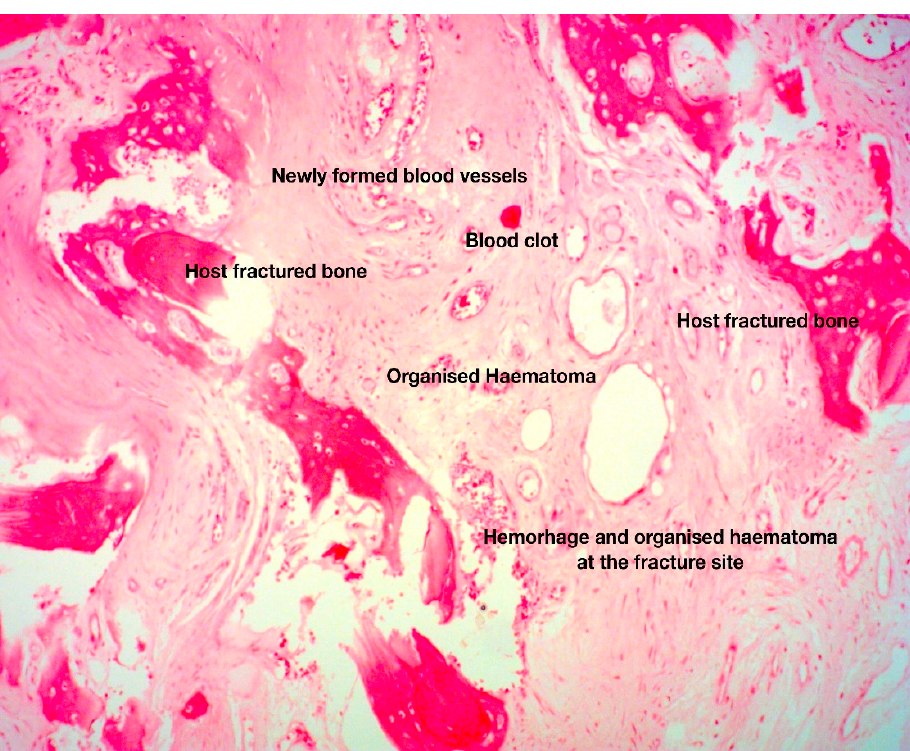
Figure 2. Histologic section of fracture site during the early, fibrous callus formation phase. The area between the fractured host bone is occupied by newly formed blood vessels in a background of loose connective tissue and organized hematoma. These are the histopathological hallmarks of the fibrovascular phase of fracture-healing (original magnification 5×).